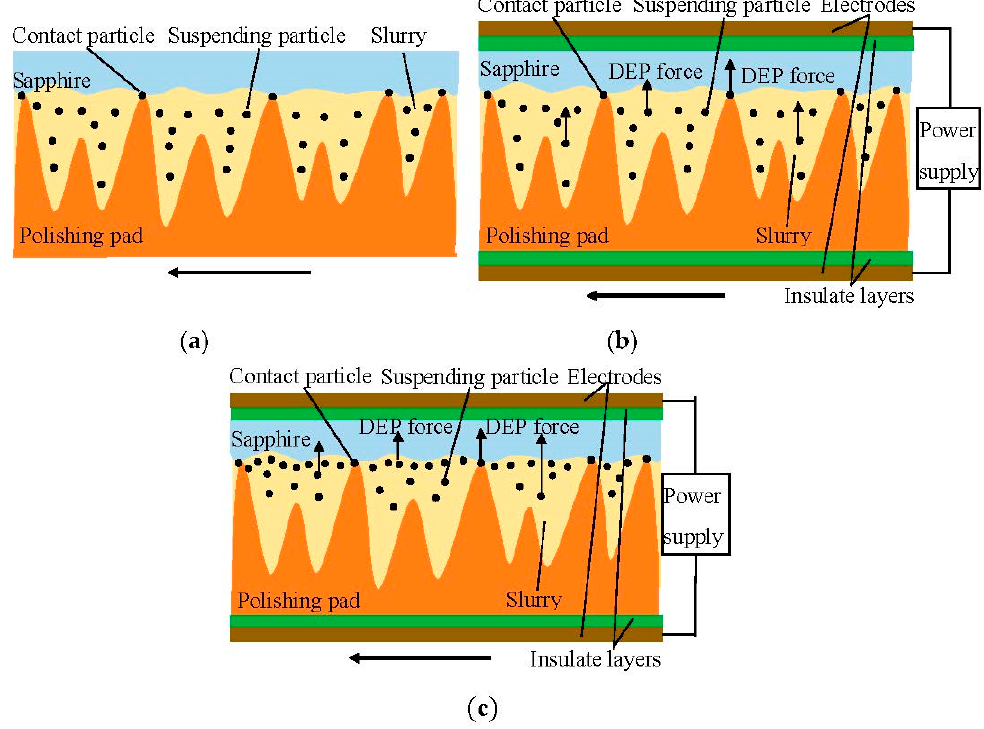
Figure 2. Mechanism of the dielectrophoresis polishing (DEPP) process: ( a ) polishing area without a non-uniform electric field; ( b ) abrasives are polarized in the non-uniform electric field; and ( c ) abrasives move and assemble to the surface of the sapphire substrate by DEP force.